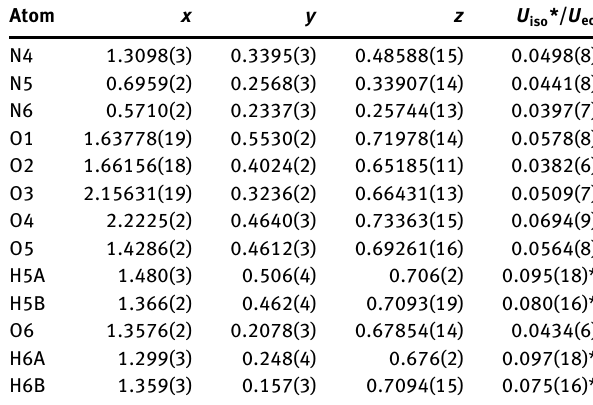
Table 2: Fractional atomic coordinates and isotropic or equivalent isotropic displacement parameters (Å 2